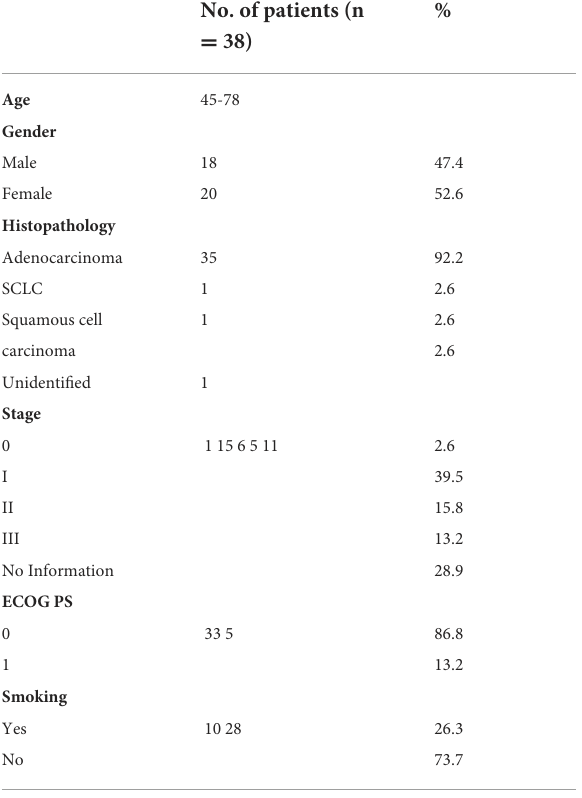
TABLE 1 Clinicopathological characteristics of patients with lung